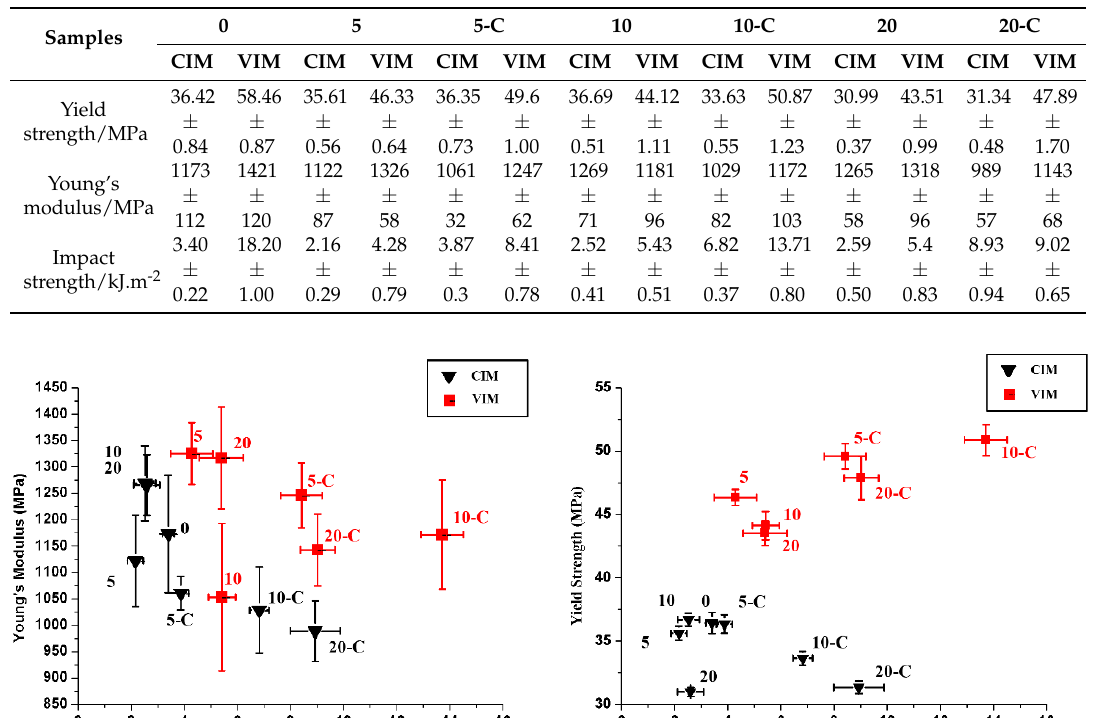
Table 2. Mechanical properties.